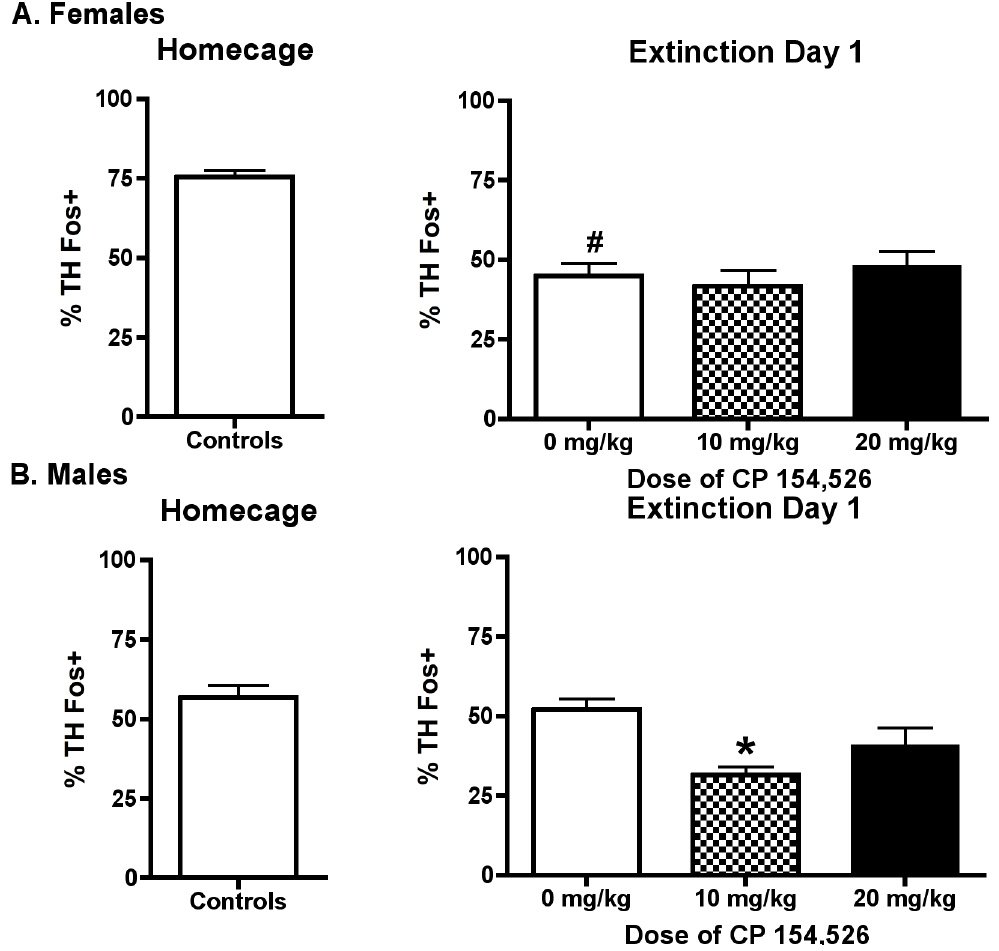
Fig 3. % TH neurons Fos+ in A2/NTS. The % of TH neurons Fos positive was decreased compared to home cage controls on ED1 in female, but not male, rats; CP (10 mg/kg) decreased the percentage of TH neurons Fos positive in in male, but not, female rats. # p < 0.05 versus home cage, * p < 0.05 versus 0 mg/kg on ED1.